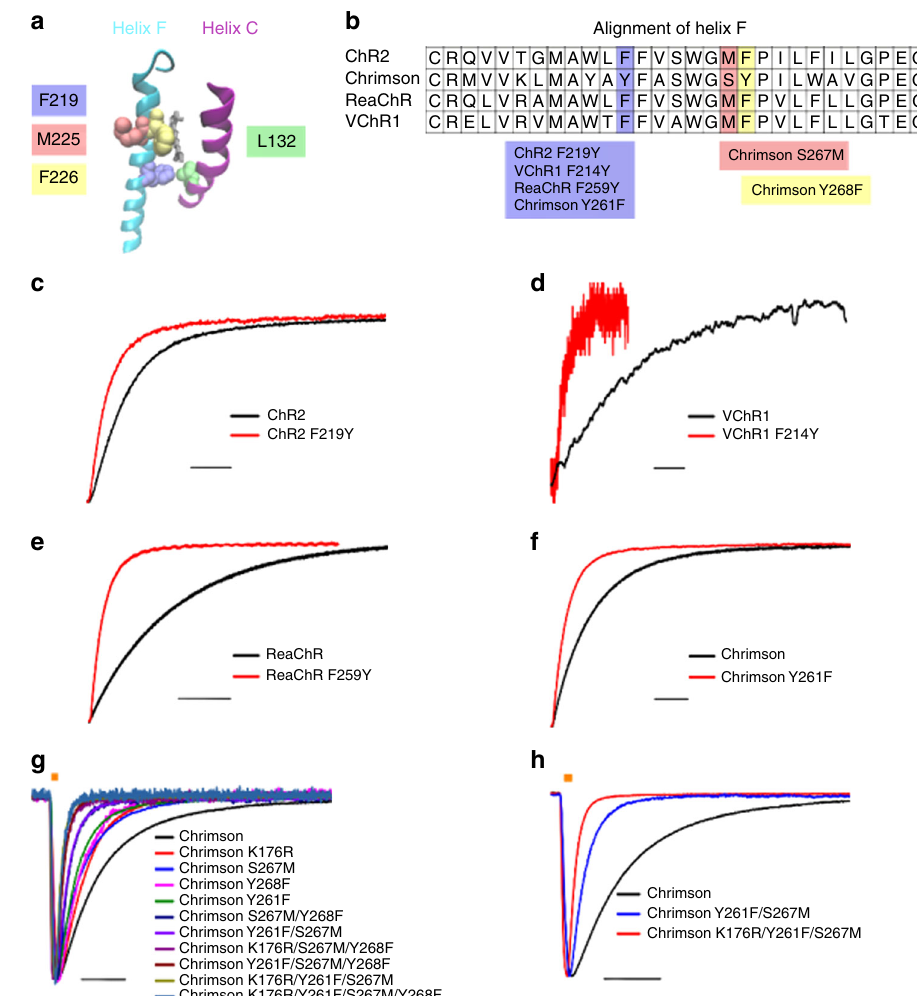
Fig. 1 Channelrhodopsin mutants with accelerated closing kinetics. a Helix F and helix C of channelrhodopsin 48 . Residues changing the off-kinetics are highlighted (ChR2 numbering). b ClustalW alignment ot the helix F of ChR2, Chrimson, ReaChR and VChR1. Colored boxes show the channelrhodopsin mutants. c – h NG cells heterologously expressing channelrhodopsin variants were investigated by whole-cell patch-clamp experiments at a membrane potential of − 60mV. Typical photocurrents of ChR2-EYFP (black trace), ChR2-EYFP F219Y (red trace) ( c ), VChR1-EYFP (black trace), VChR1-EYFP F214Y (red trace) ( d ), ReaChR-Citrine (black trace), ReaChR-Citrine F259Y (red trace) ( e ), Chrimson-EYFP (black trace) and Chrimson-EYFP Y261F (red trace) ( f ) immediately after cessation of 0.5 s illumination at a saturating light intensity of 23mW/mm -2 and a wavelength of c λ = 473nm, d λ = 532nm, e λ = 532 nm and f λ = 594nm. g Typical photocurrents of Chrimson-EYFP mutants, which were measured in response to 3 ms light-pulses (23mW/mm 2 , λ = 594 nm). h For clear illustration solely the photocurrents of Chrimson-EYFP, Chrimson-EYFP Y261F/S267M (f-Chrimson-EYFP) and Chrimson-EYFP